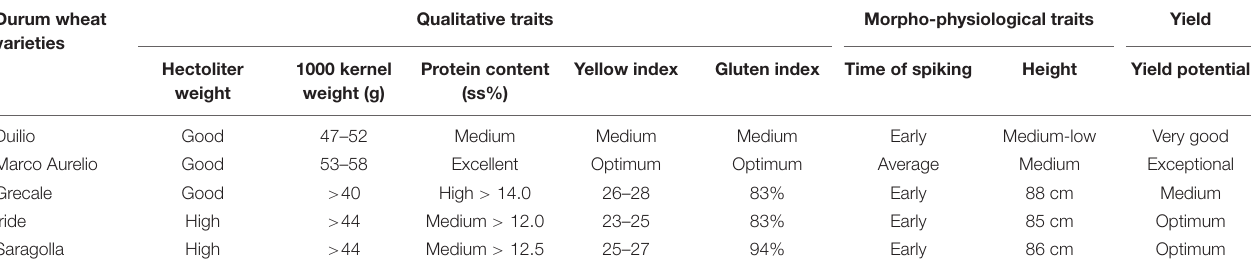
TABLE 1 | Main qualitative and morpho-physiological traits, and yield potential of the five durum wheat varieties used in the phenotyping experiment, as reported by their respective seed companies. Durum wheat Qualitative traits Morpho-physiological traits Yield varieties